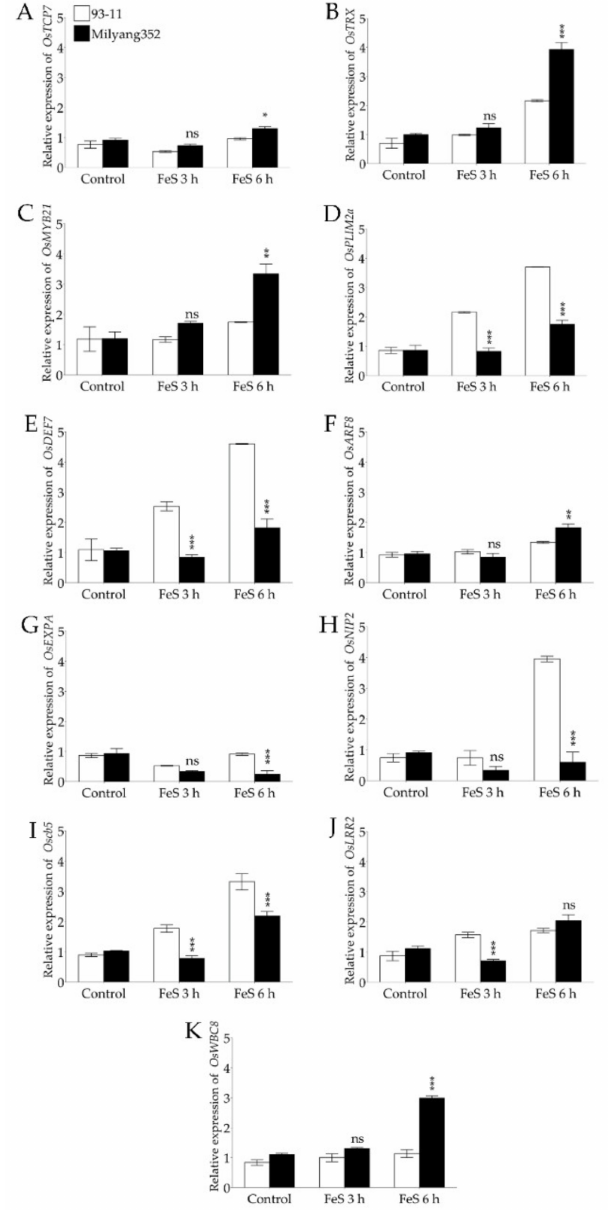
Figure 5. Over time transcript accumulation patterns of qROL-2 related genes associated with radial oxygen loss (ROL) in rice in response to FeS treatment. Relative expression of ( A ) OsTCP7 , ( B ) OsTRX , ( C ) OsMYB21 , ( D ) OsPLIM2a , ( E ) OsDEF7 , ( F ) OsARF8 , ( G ) OsEXPA , ( H ) OsNIP2 , ( I ) Oscb5 , ( J ) OsLRR2 , and ( K ) OsWBC8 in the roots of 14-day-old rice seedlings of 93-11 (P1, indica low